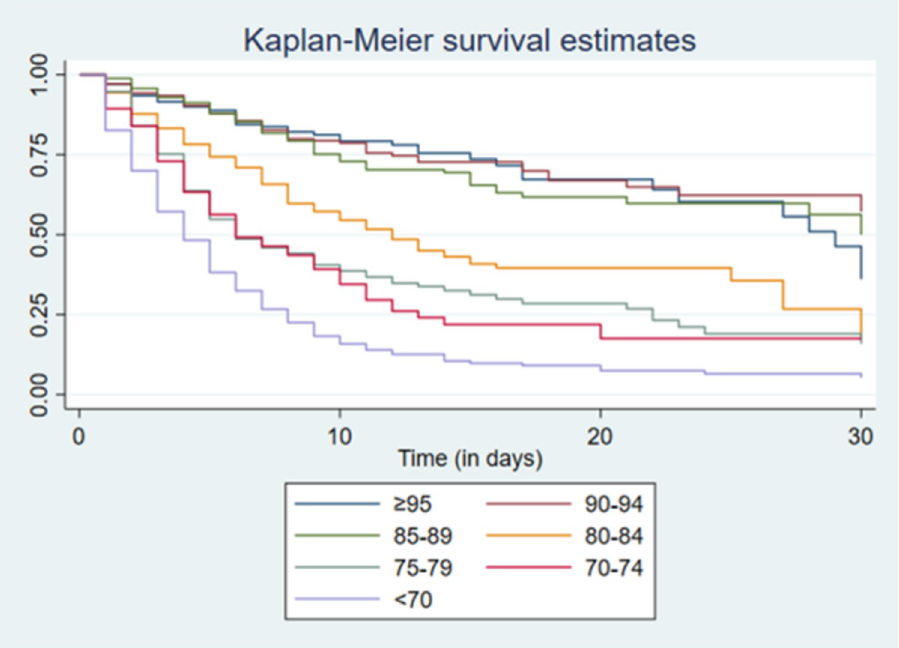
Fig 2. Kaplan-Meier survival curves comparing oxygen saturation of hemoglobin (SaO2) at admission in patients hospitalized with COVID-19 between April and August 2020 in Hospital Nacional Hipolito Unanue. Lima, Peru. Log rank test: p < 0,001.